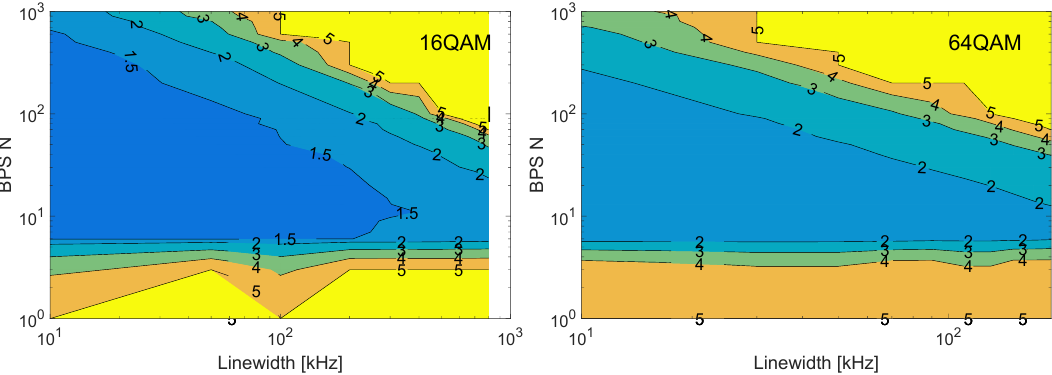
Figure 6. Optimization of the BPS algorithm filter length N using model A simulator for ( left ) 16-QAM and ( right ) 64-QAM modulation formats. Both plots show the optical signal to noise ratio (OSNR) penalty in dB computed at a bit-error rate (BER) of 10 − 4